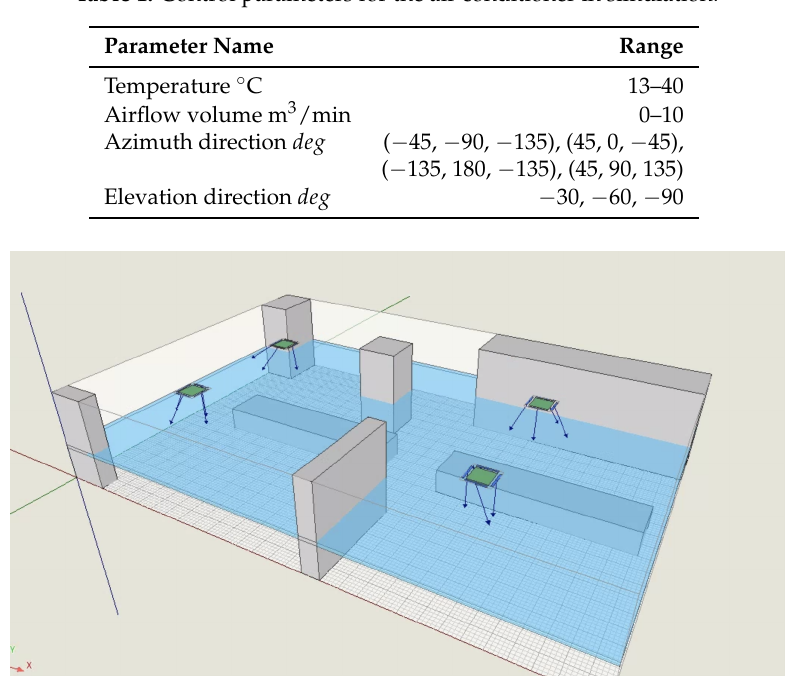
Figure 4. Large room with four air conditioners under the ceiling.